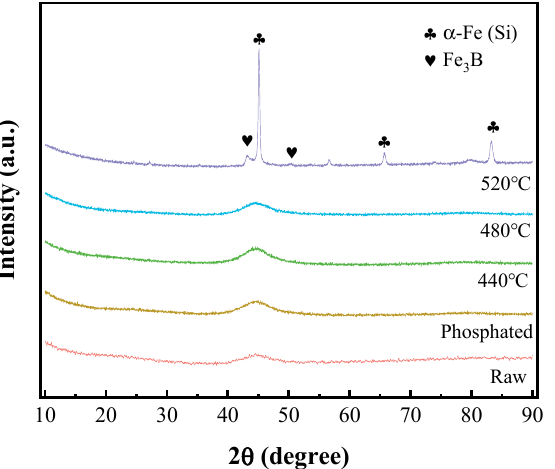
Figure 3. The XRD patterns of raw powders, phosphated powders and powders annealed at 440 °C, 480 °C and 520 °C.